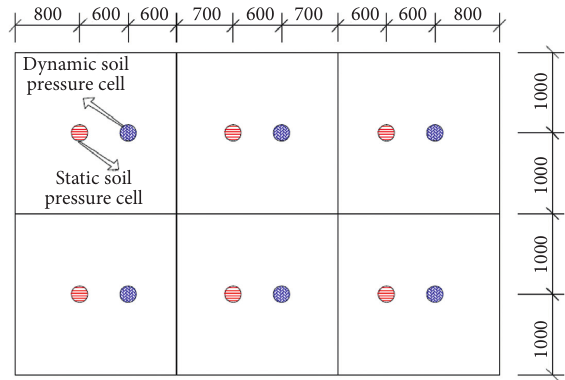
Figure 6: Floor plan of pressure